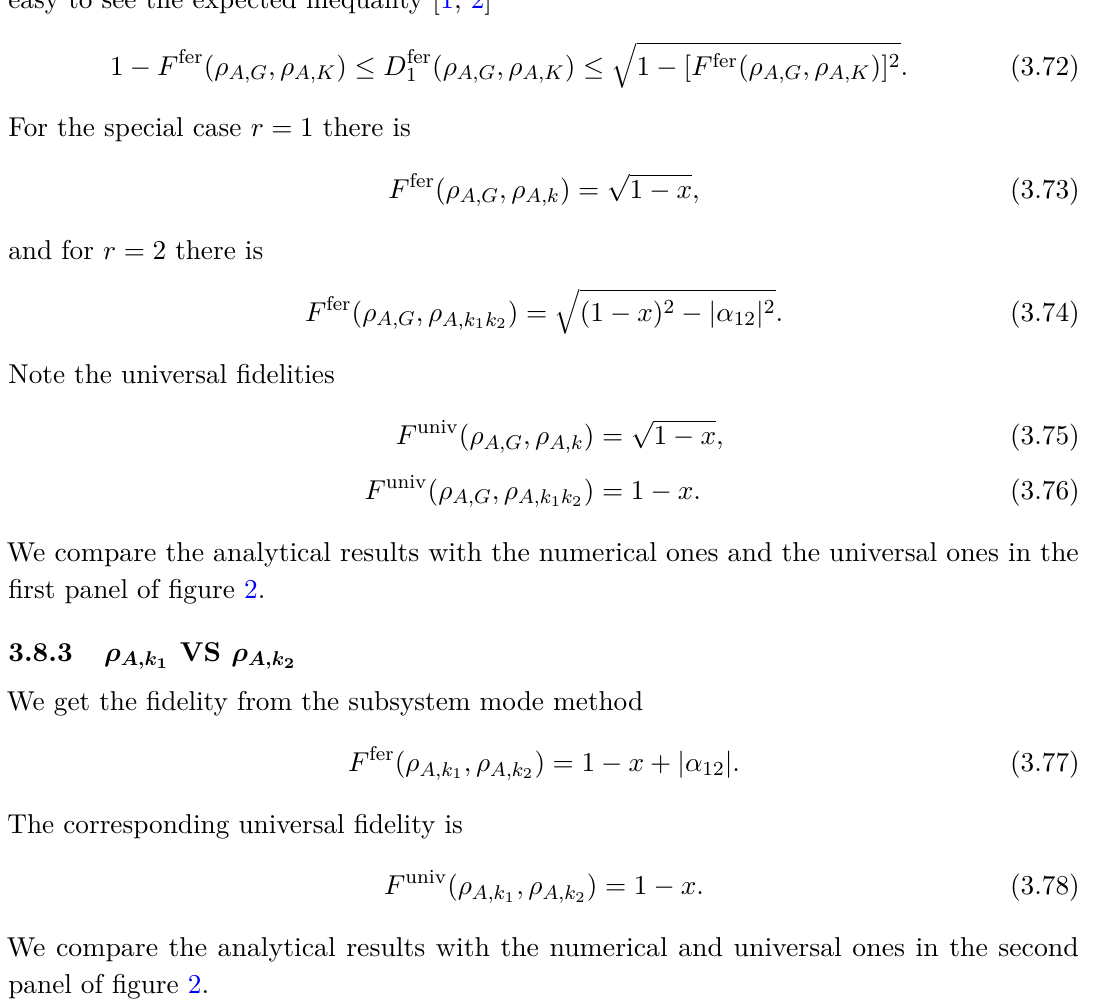
= 1 / 2 . 1 ≤ 1 , it is A,G,K